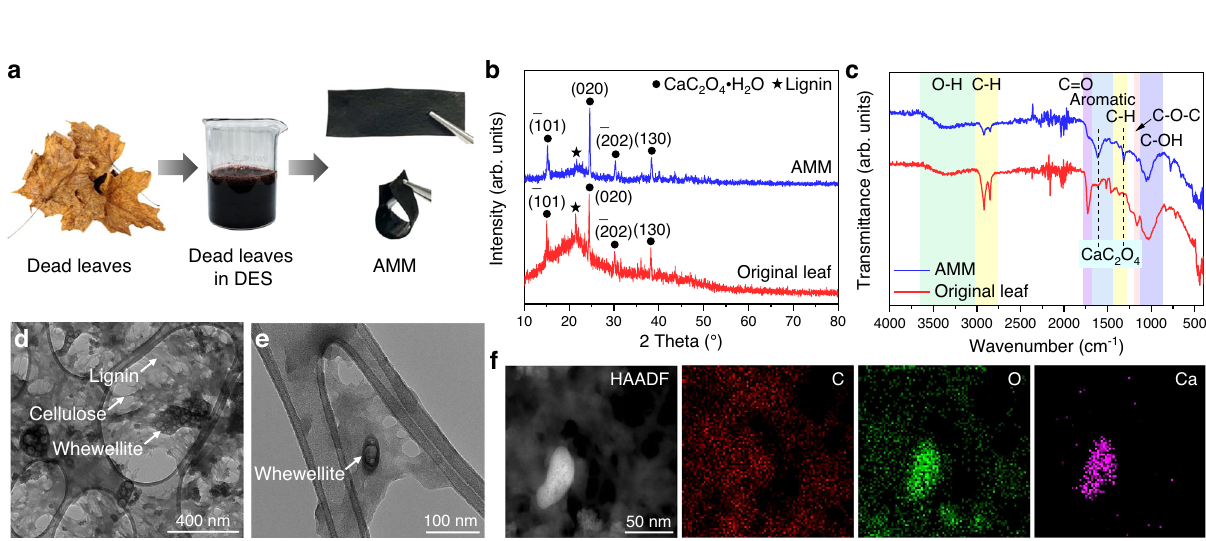
Fig. 2 | Synthesis and composition analyses of AMM. a Visual illustration of the conversion from red maple dead leaves to AMM with deep eutectic solvent (DES).